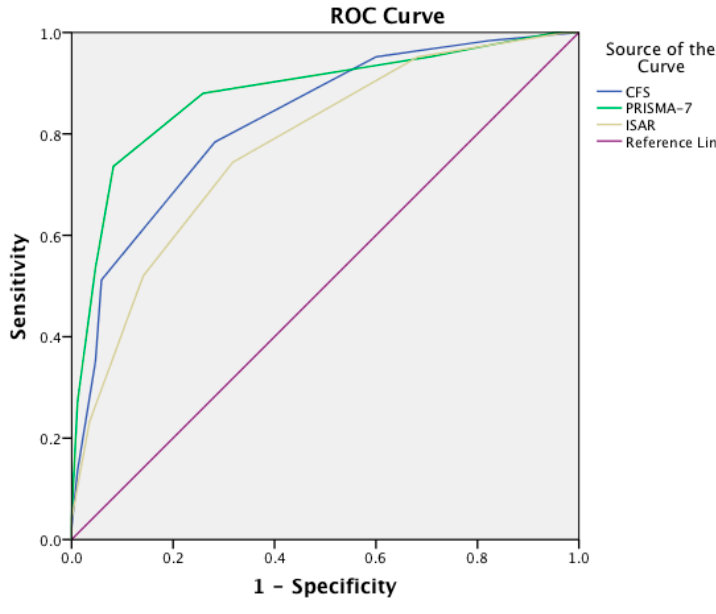
Figure 1. Receiver operating characteristic curves with area under the curve scores showing the accuracy of the Clinical Frailty Scale (CFS), Programme of Research to Integrate Services for the Maintenance of Autonomy 7 (PRISMA-7) tool, and the Identification of Seniors at Risk (ISAR) tool in differentiating frail from non-frail older adults in the Emergency Department (classification based on the comprehensive geriatric assessment ).